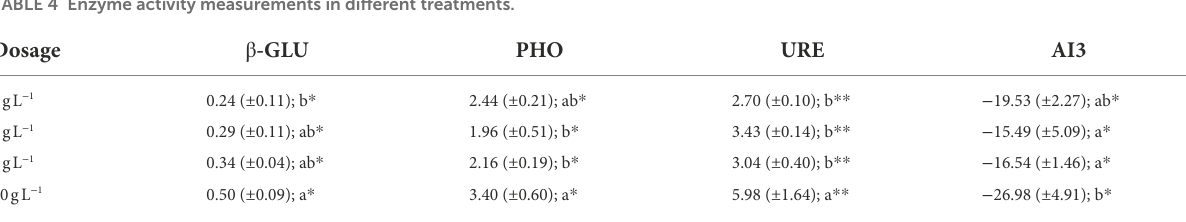
TABLE 4 Enzyme activity measurements in different